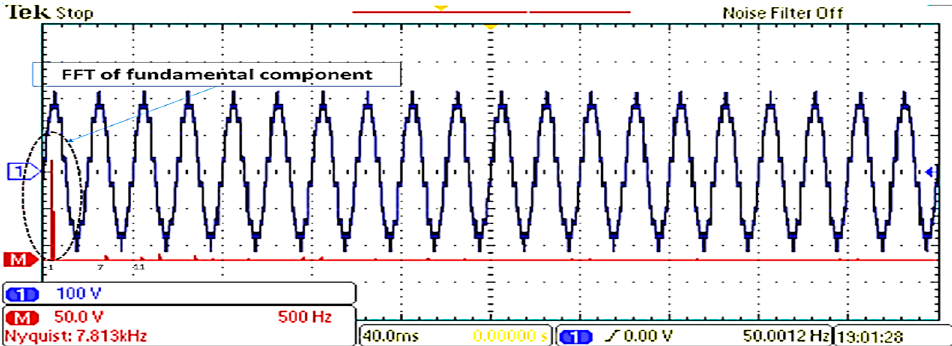
Figure 12. The output phase voltage waveform of two phases V A and V B .